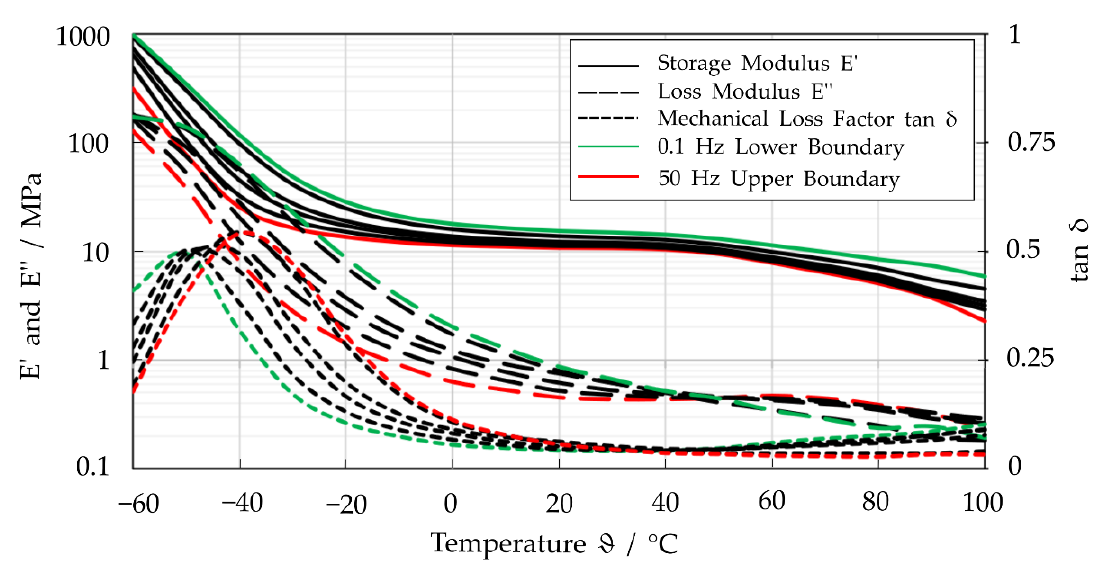
Figure 4. Averaged values for storage modulus 𝐸′ , loss modulus 𝐸′′ and mechanical loss factor tan 𝛿 at the frequencies of 𝑓 = 0.1, 0.3, 0.5, 1, 2, 3, 5, 10, 30, 50 Hz.